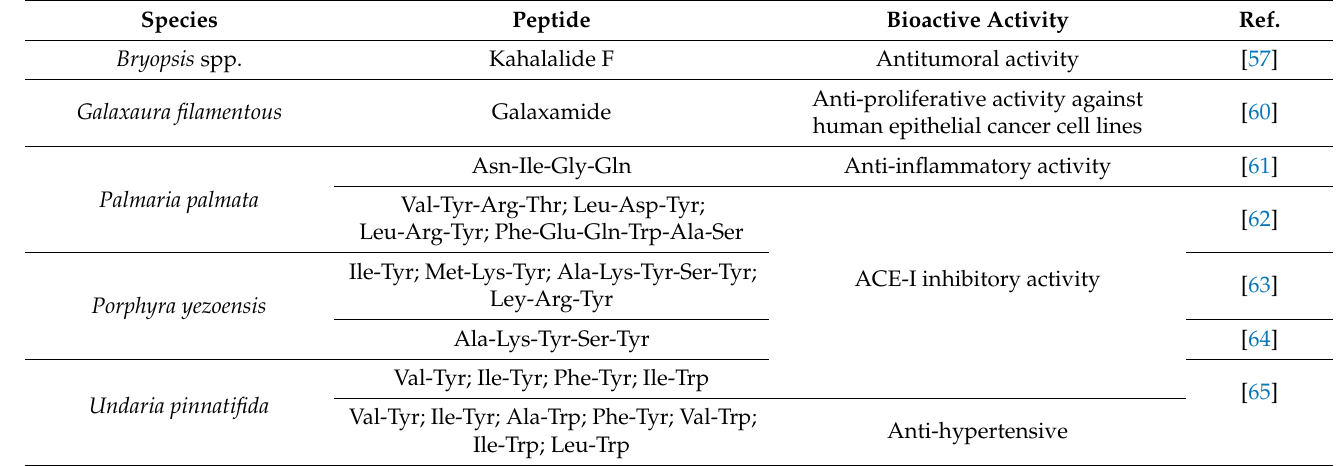
Table 2. The bioactivities of several macroalgal